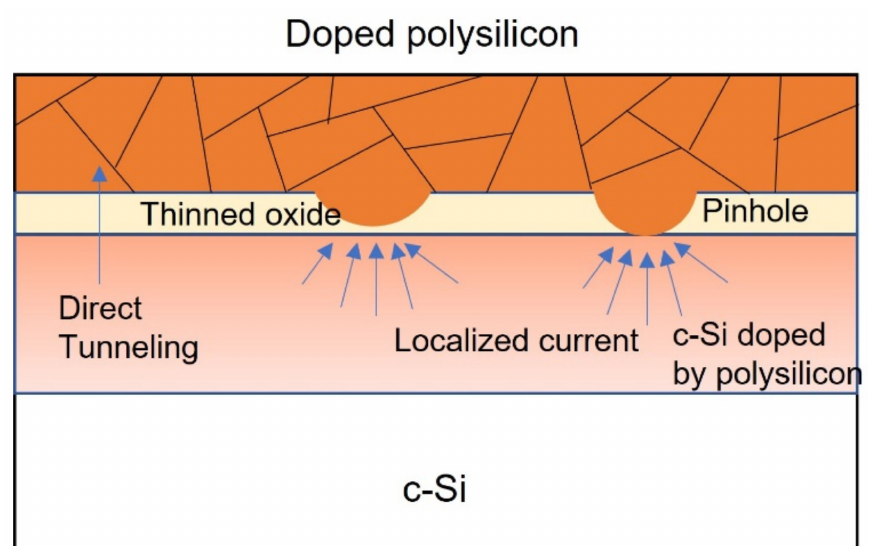
Figure 7. Schematic diagram of a POLO contact with a non-uniform SiO x layer. The possible conduction paths include direct tunneling, localized conduction near thinned SiO x and localized conduction through